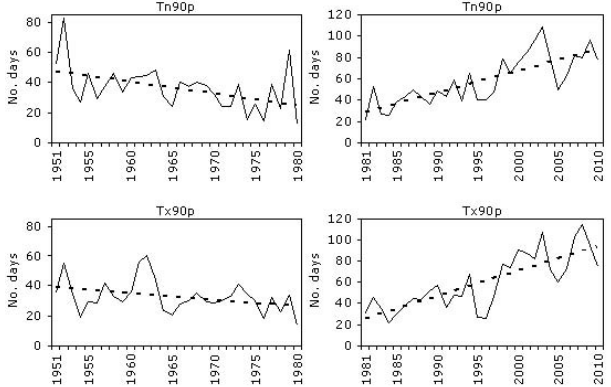
Fig. 2. Tn10p and Tn90p in Herceg Novi in 2003.